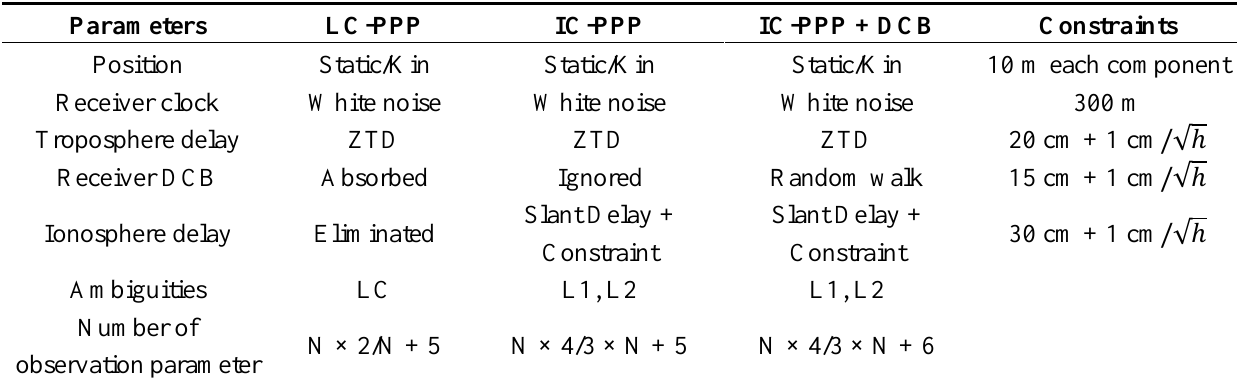
Table. 1. Parameter schemes for IC-PPP estimation no italic